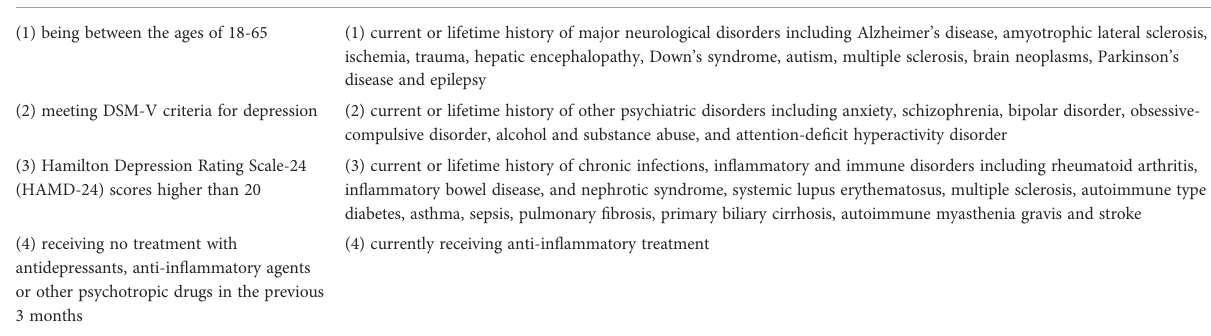
TABLE 1 Common criteria for patient inclusion and